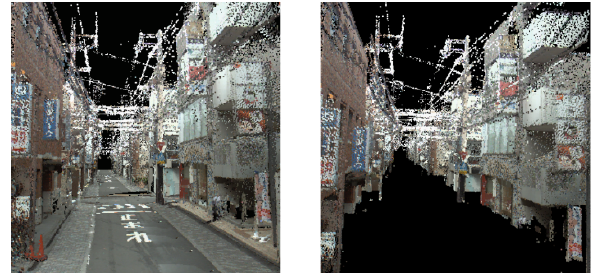
Figure 6. Left: Raw laser-scanned point cloud of Sanjo Street in Kyoto City ( 2 . 3 × 10 ! points). Right: Processed point cloud ( 1 . 4 × 10 ! points), in which the ground surface was removed for the preparation of the collision detection simulation.